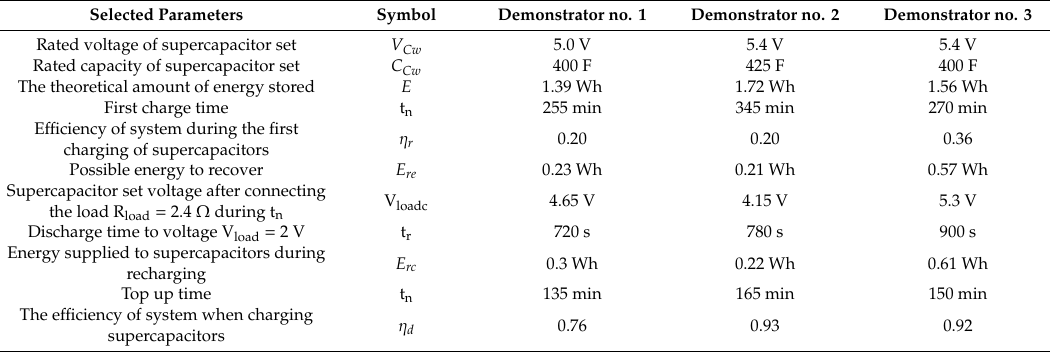
Table 3. Selected electrical parameters of all investigated energy storage systems. Selected